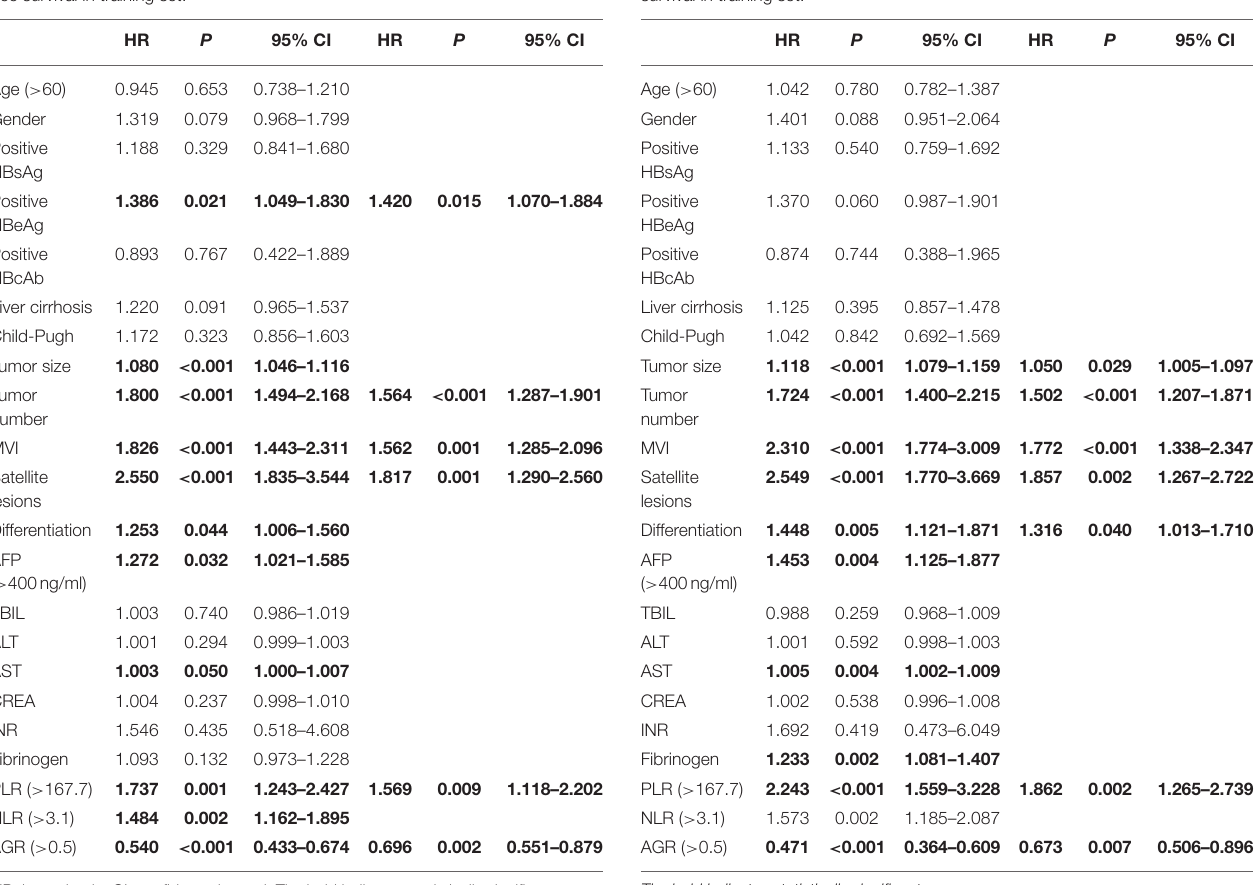
TABLE 2 | Univariate and multivariate analysis of factors related with recurrence free survival in training set.